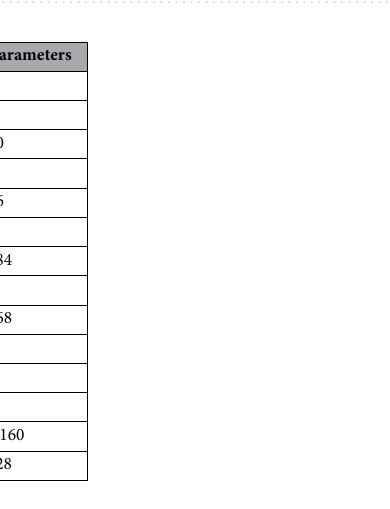
Table 1. Summarized information on the designed